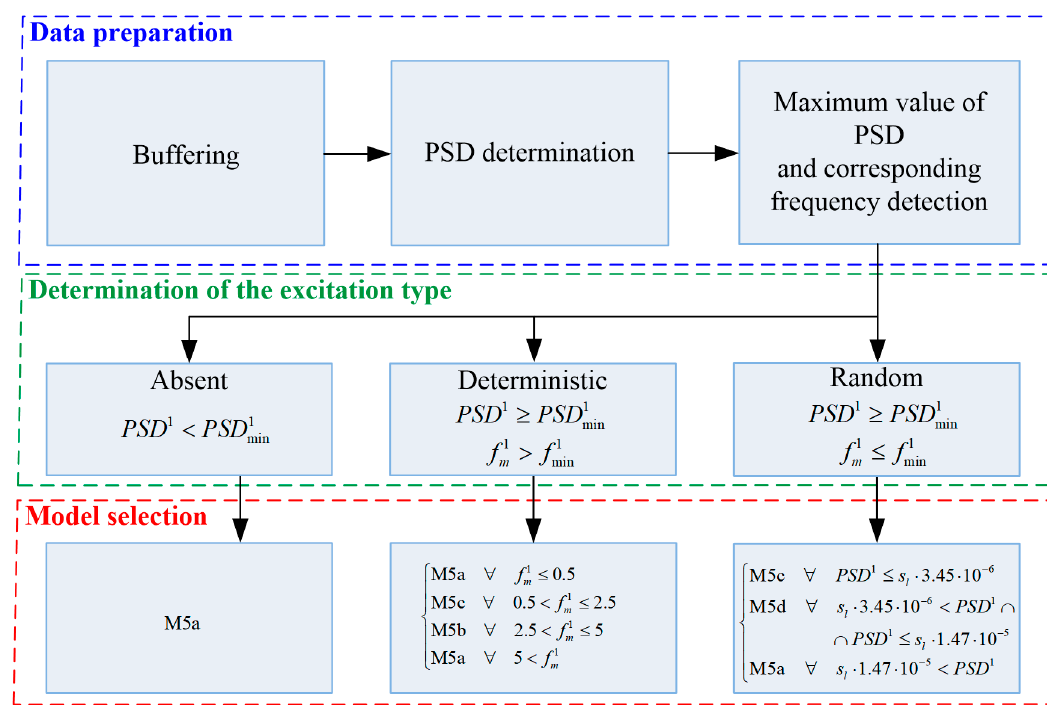
Figure 8. Diagram of the HVRS operation.